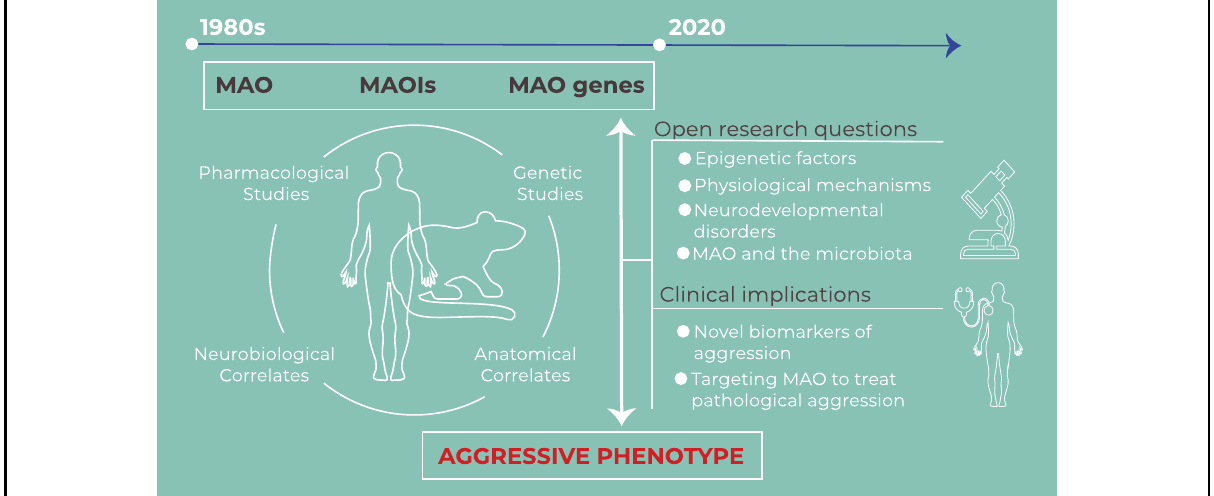
Fig. 1 Graphical abstract on the associations between Monoamine Oxidases and aggressive behaviour. MAO: monoamine oxidases; MAOIs: monoamine oxidases